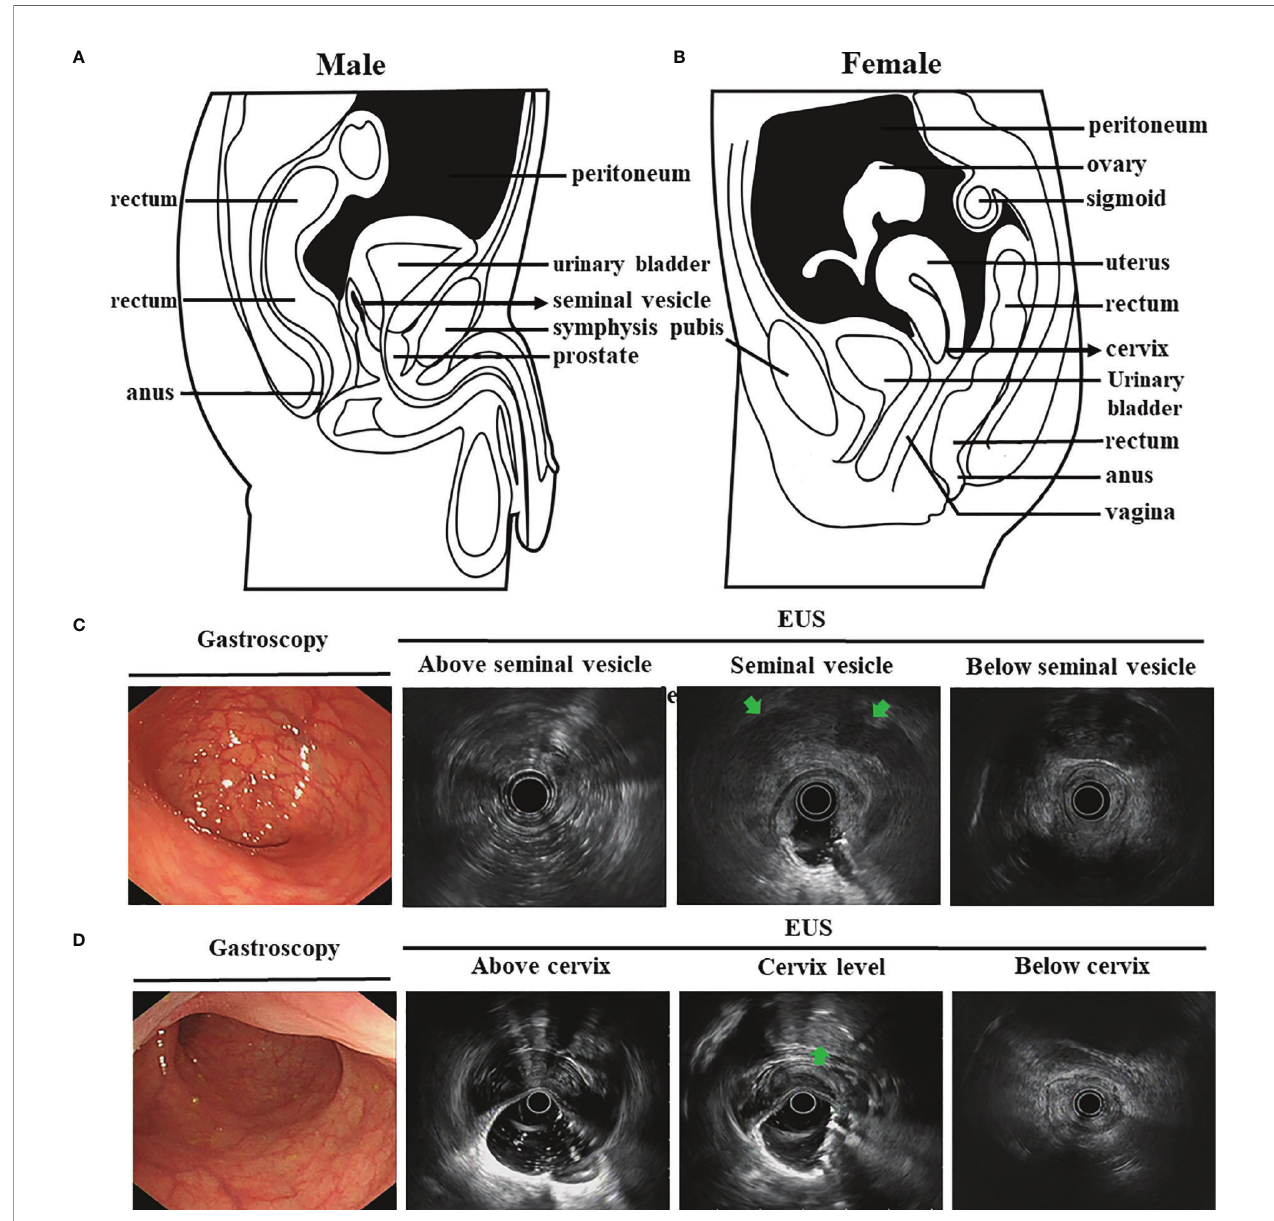
FIGURE 1 | The schematic diagrams and EUS images for normal pelvic viscera and peritoneal re fl ection. (A, B) . The schematic diagrams show normal pelvic viscera and peritoneal re fl ection for male (A) and female (B) (black shaded area); (C, D) . EUS images for normal pelvic viscera about white light endoscopy, peritoneal re fl ection marker for male seminal vesicle (C) and female cervix level (D) . The seminal vesicles and cervix are shown at the